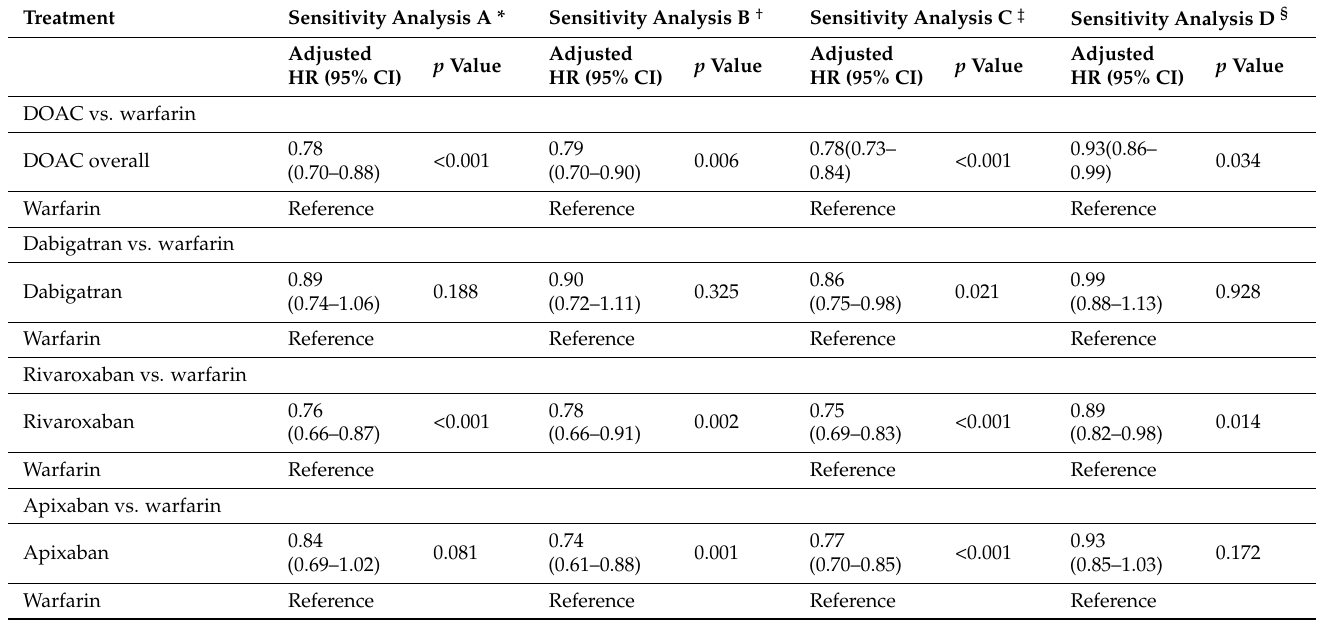
Table 5. Comparison for the incidence of osteoporosis in patients treated with DOACs versus warfarin in sensitivity